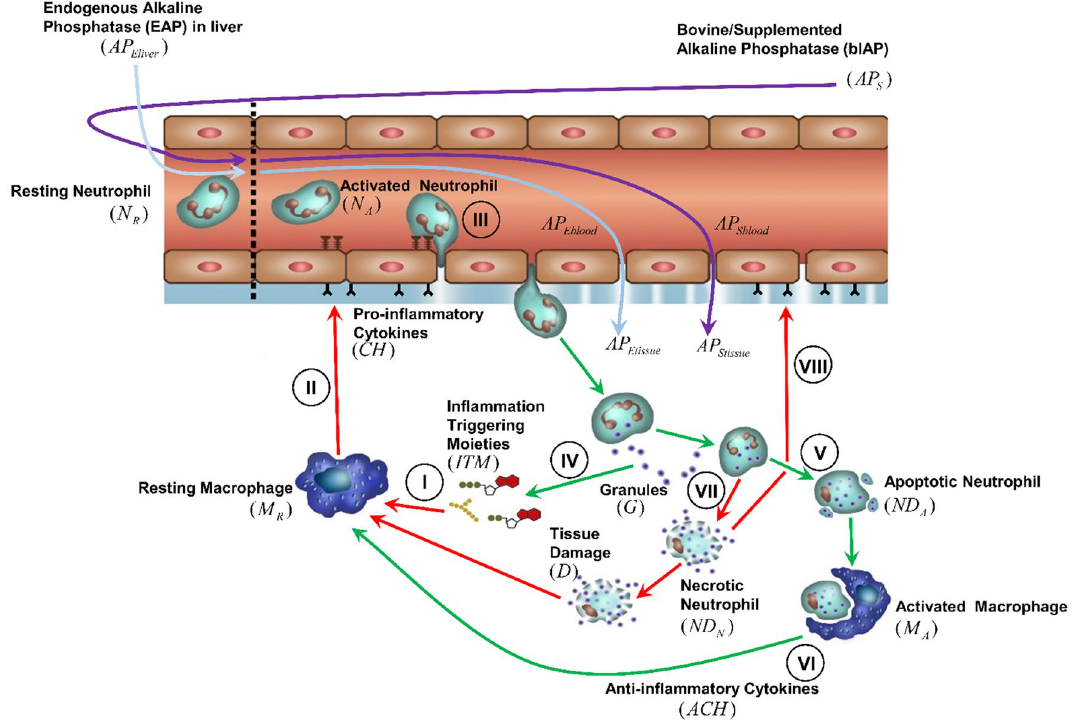
Figure 7. Overview of the innate immune response to inflammation. For details see the main text.